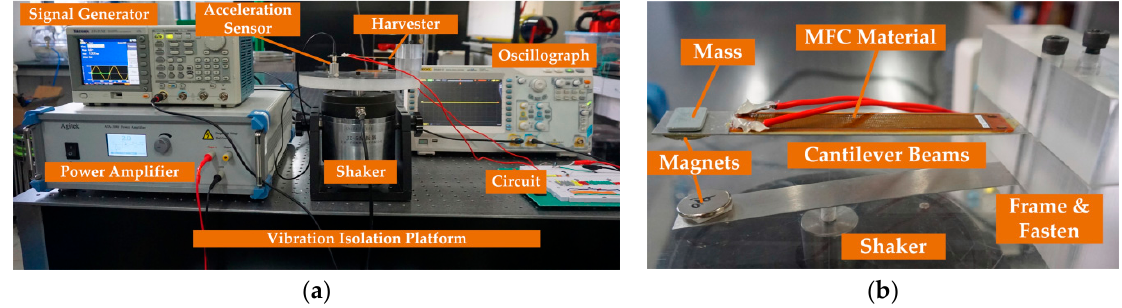
Figure 5. Experimental prototype: ( a ) Overview of the platform; ( b ) Close-up of the harvester. Table 3. Parameters of the prototype.